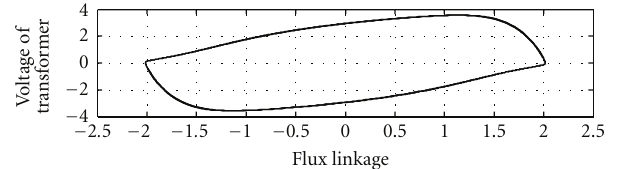
Figure 11: Phase plan diagram with q = 7 (neutral resistance e ff ect).